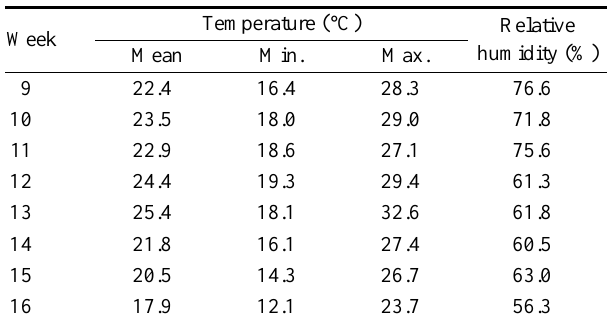
Table 1. Average minimum and maximum temperature and average relative humidity from 9 to 16 weeks of age of the trial Temperature (°C) Relative Week